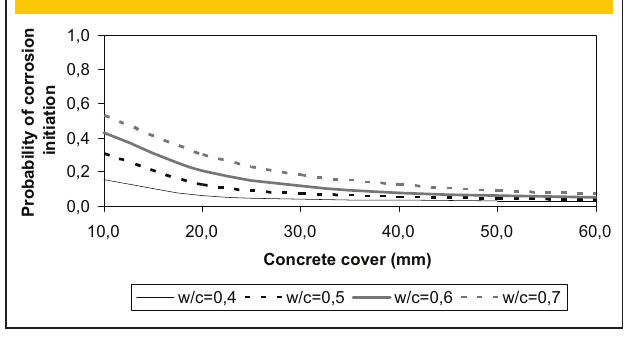
Figure 8 – Evolution for probability of corrosion initiation – C.A.II structural life-time = 15 years